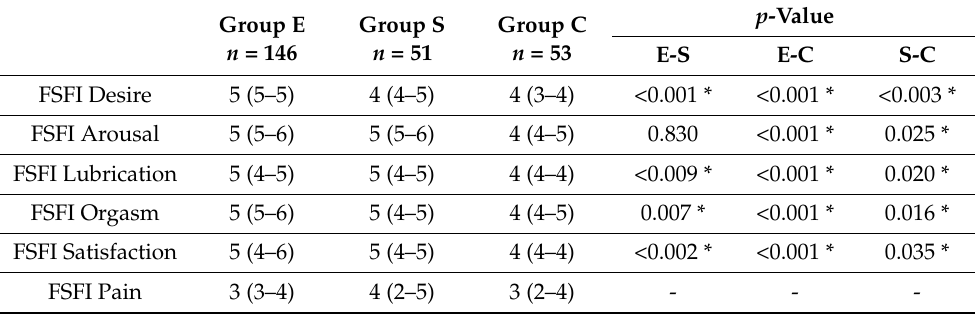
Table 7. Comparison of categories of AITD in terms of FSFI scores by separate